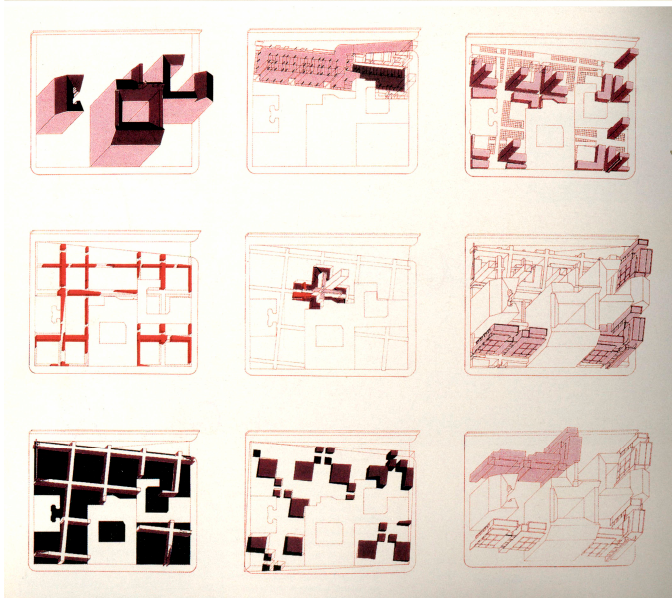
Figure 10. Peter Eisenman, plate for IBA 84. Study